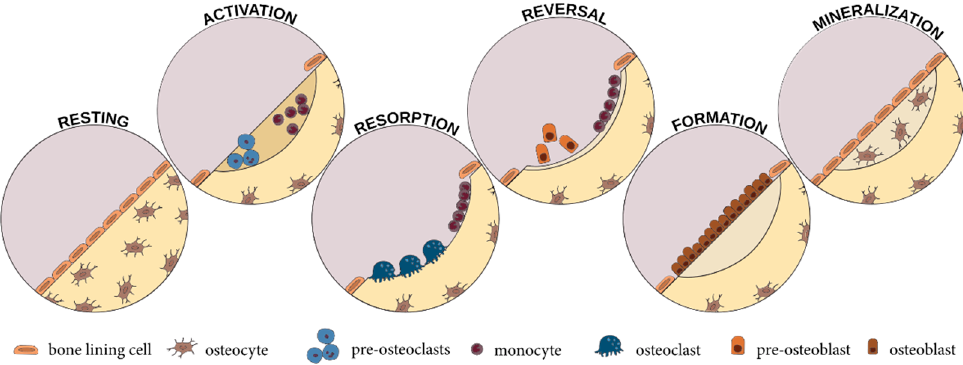
Figure 3. The main stages of bone remodeling [89].